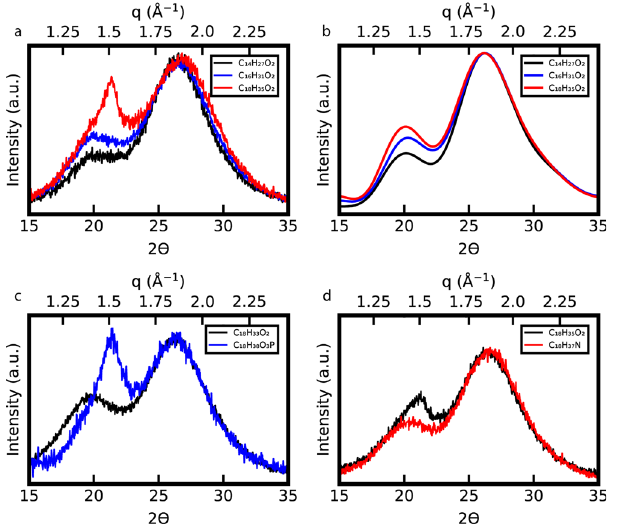
Fig. 3 Experimental and simulated powder X-ray diffraction spectra of indium phosphide quantum dots capped with carboxylates of different lengths. a Experimental powder X-ray diffraction spectra of indium phosphide quantum dots capped with myristate (C 14 H 27 O 2 ), palmitate (C 16 H 31 O 2 ), and stearate (C 18 H 35 O 2 ) ligands. b Simulated powder X-ray diffraction spectra of indium phosphide quantum dots capped with myristate, palmitate, and stearate ligands. c Experimental powder X-ray diffraction spectra of indium phosphide quantum dots initially capped with oleate (C 18 H 33 O 2 ) and after ligand exchange with octadecylphosphonate (C 18 H 38 O 3 P). d Experimental powder X-ray diffraction spectra of indium phosphide quantum dots initially capped with stearate and after ligand exchange with oleylamine (C 18 H 37 N). Note that the powder X-ray diffraction pattern of stearate (C 18 H 35 O 2 ) capped indium phosphide quantum dots in d differs from the one in panel a as the quantum dots are larger and from a separate synthesis. Cu K- α ð λ ¼ 1 : 5418Å Þ is the X-ray source for all experimental and simulated powder X-ray diffraction spectra.